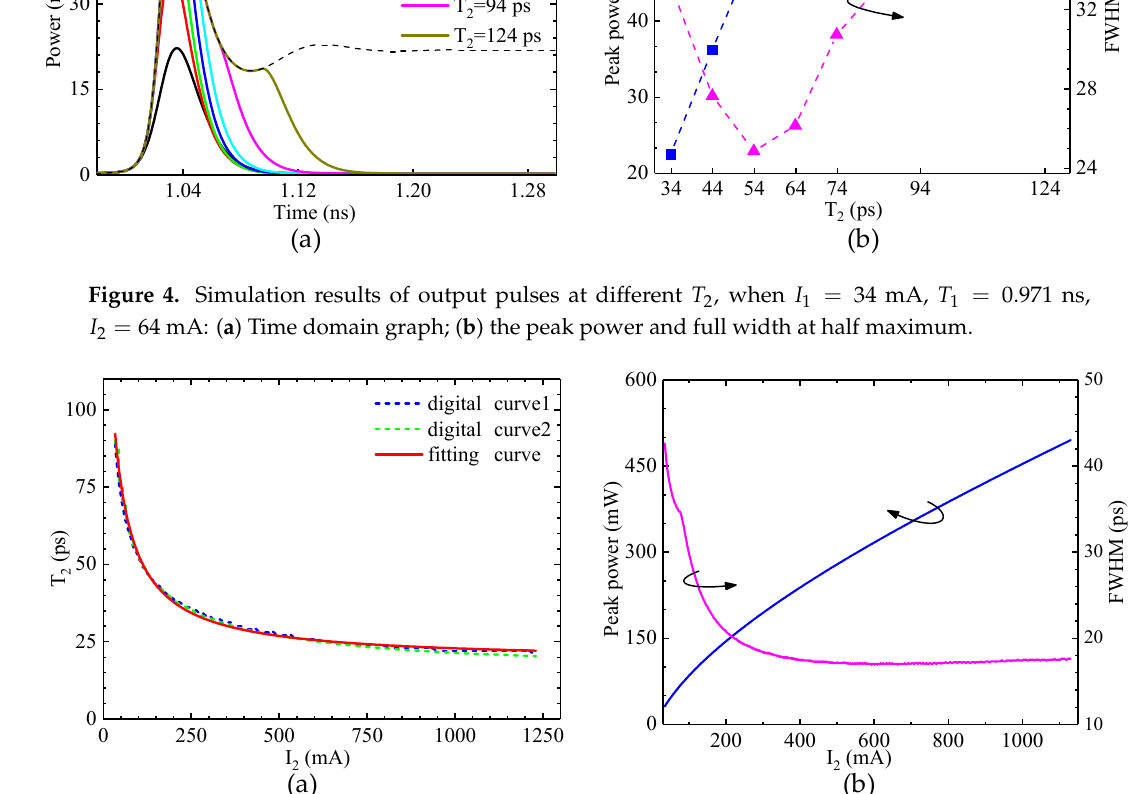
I and T based on conclusion one (green 2 2 34 I = mA, 0.971 T = ns; ( b ) The peak power and full 1 1